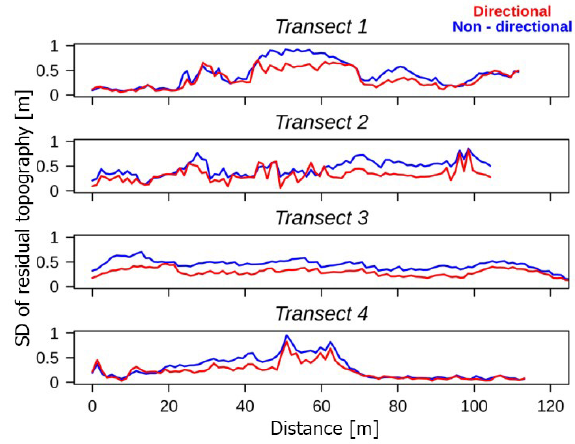
Figure 7. Analysis of the four transects from the Braema study area using the SD of residual topography algorithm (red) or without (blue) direction in the